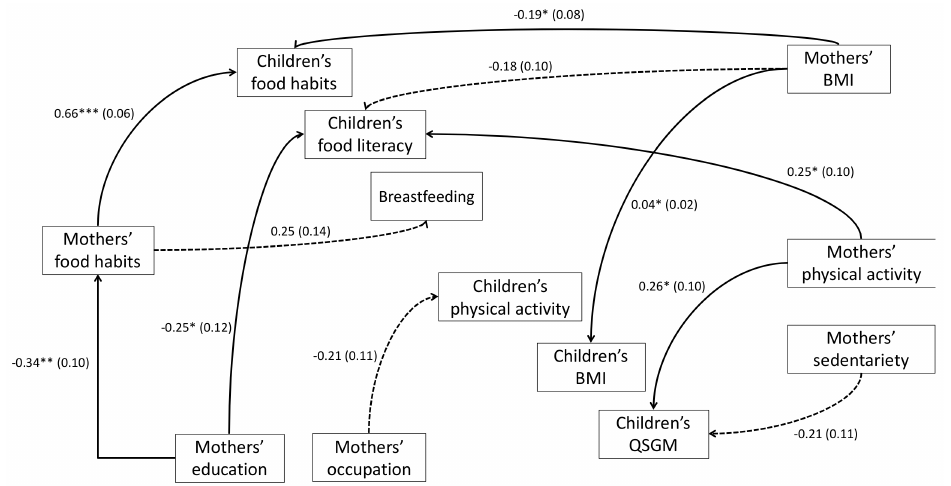
Figure 1. Interactions between maternal and their children food and PA habits. Note: Path coefficients are presented as standardised regression weights and standard errors in parenthesis. Only significant relationships are showed; asterisks indicate the significance level (* p -value < 0.05; ** p -value < 0.01; *** p -value < 0.001). The dashed lines represent relationships with a significance level slightly above 0.05 (mothers’ BMI/children’s FL score p = 0.080; mothers’ occupation/children’s PA p = 0.061; mothers’ sedentariness/QSGM p = 0.053; mothers’ food habits/breastfeeding p = 0.073). BMI: body mass index; QGMD: quotient of gross motor